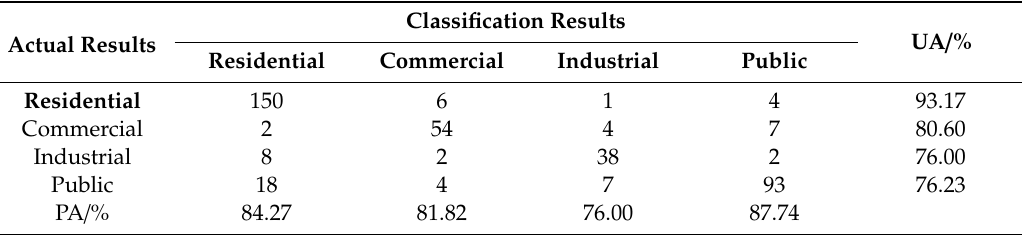
Table 4. Confusion matrix of results based on multi-source features using the random forest (RF) model (Level I